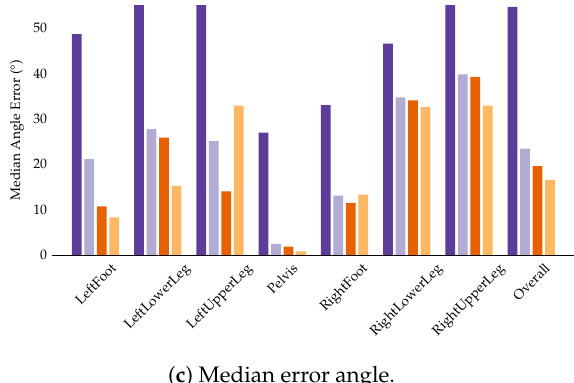
Figure 13. Evaluation results for the I2S alignment problem on dataset B . The bar plots show the maximum, mean and median angle errors for all segments over all windows, axes and considered (nine) IMU configurations. These were obtained through cross validation.